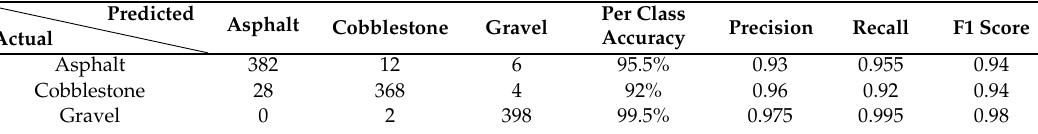
Table 3. Confusion matrix for road pavement type only.